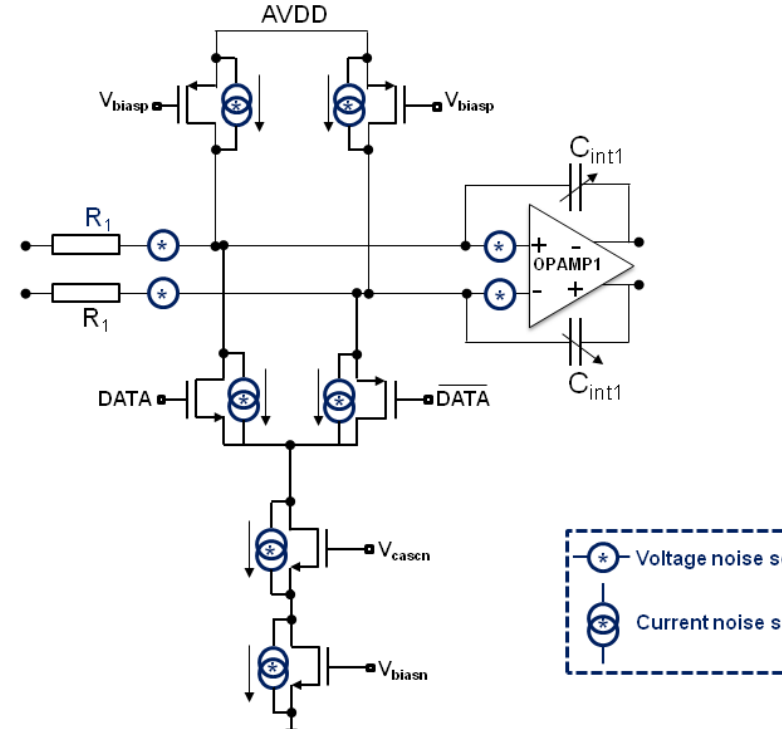
Figure A1. Noise sources in the front-end of the ∆Σ